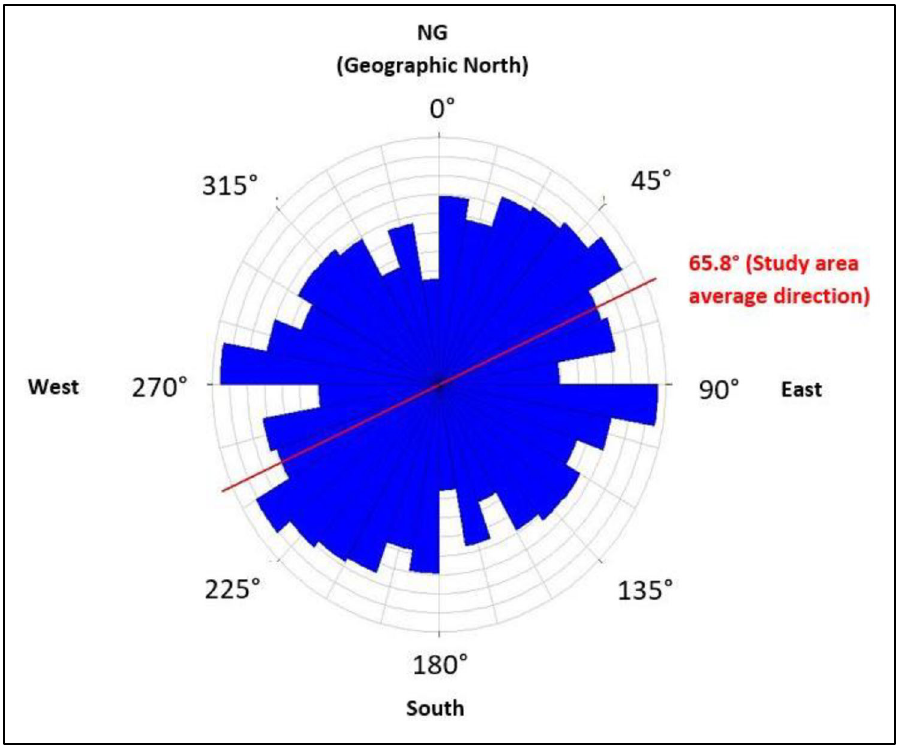
Figure 4. Rosette diagram of fractures orientations calculated from extracted lineaments.